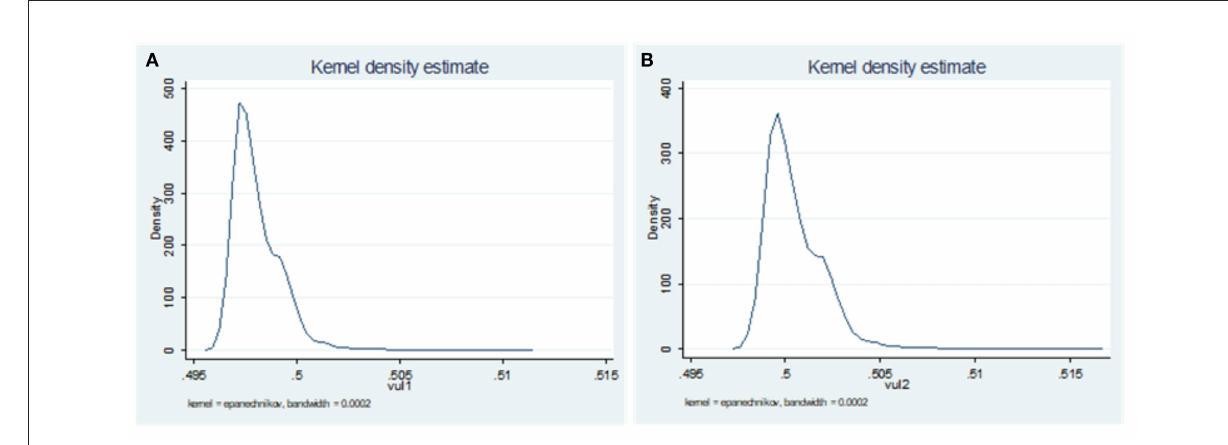
FIGURE1 Kernel Density of vulnerability to poverty. (A) VEP 1 -poverty line = 1.9$; (B) VEP 2 -poverty line =